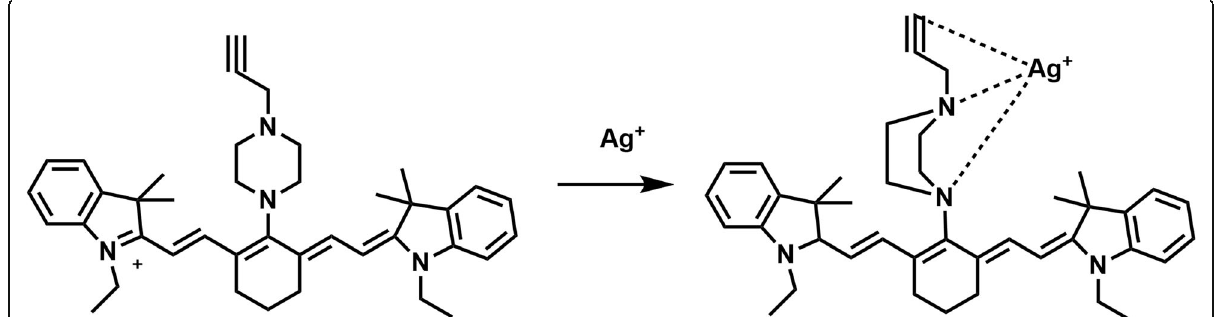
Fig. 9 Proposed binding mechanism of probe 1 in the presence of Ag +